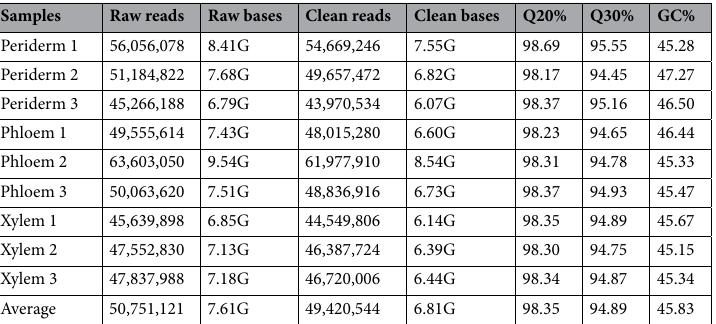
Table 1. Statistics of transcriptome data for S. flavescens.